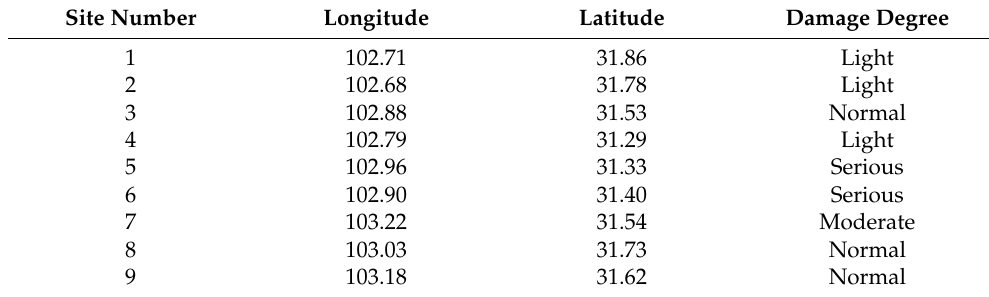
Table A1. The data of some ground survey sites in 2014 (survey time: 1 May to 31 October 2014).